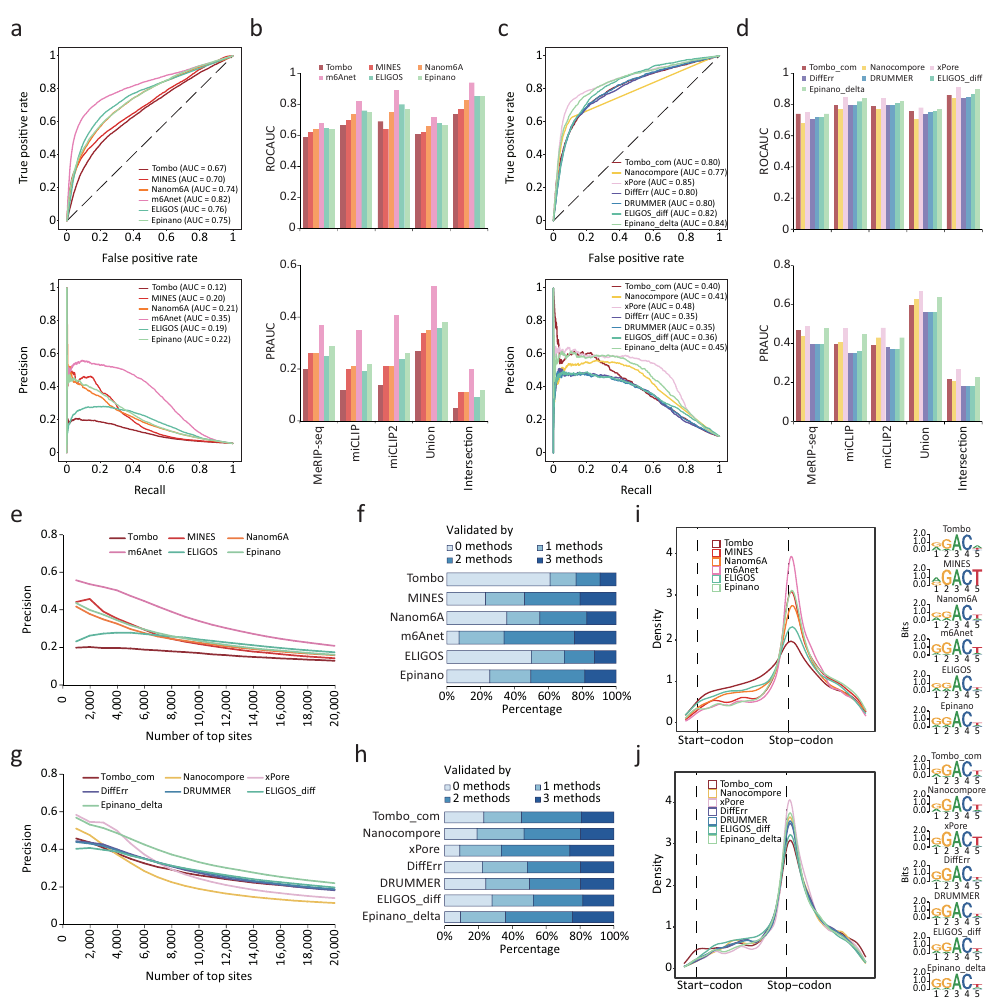
Fig. 2 | Performance evaluation of ten tools for m6A detection capability. a Receiver operating characteristic (ROC) curve (top) and Precision Recall (PR) curve(bottom)forcandidate sitesdetected bysingle-modetoolsusing themiCLIP dataasgroundtruth.Areaunderthecurve(AUC)isindicatedinparentheses. b ROC AUC (top) and PR AUC (bottom) for candidate sites detected by single-modetools usingdifferentNGS-baseddatasetsasgroundtruth. c ROCcurve(top)andPRcurve (bottom) for candidate sites detected by compare-mode tools using the miCLIP dataasgroundtruth.AUCisindicatedinparentheses. d ROCAUC(top)andPRAUC (bottom)forcandidatesitesdetectedbycompare-modetoolsusingdifferentNGS- based datasets as ground truth. e Precision curve for top 20,000 m6A sites detectedby single-mode toolsusing the miCLIP dataasground truth. f Percentage